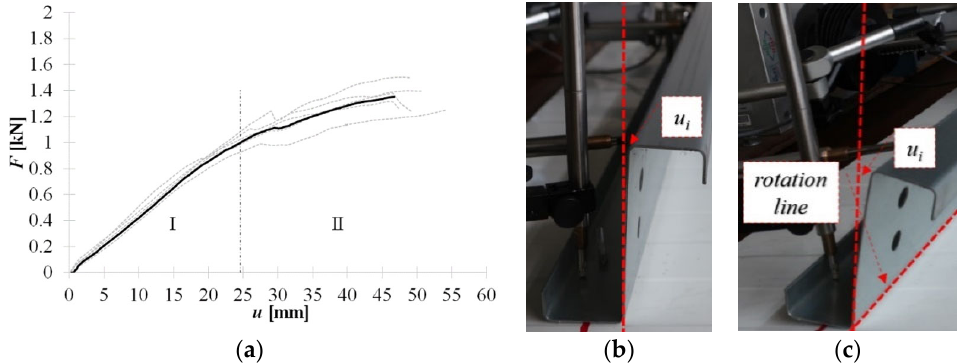
Figure 8. Self ‐ drilling fasteners (F): ( a ) equilibrium load ‐ displacement paths, ( b ) initial (up to 0.05 kN) response, ( c ) linear response (stage I).